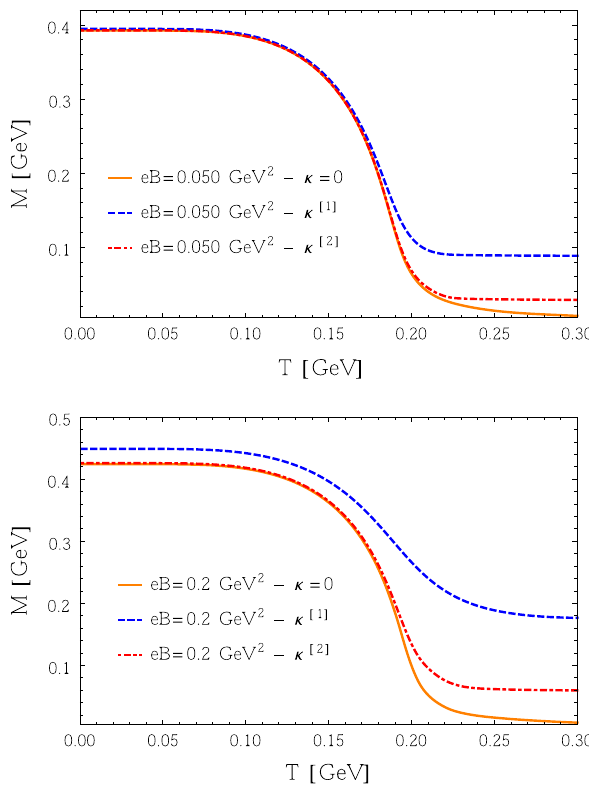
Fig. 3 Effective quark masses as a function of the temperature for eB = 0 . 05 GeV 2 (top panel) and eB = 0 . 2 GeV 2 (low panel) with fixed values of